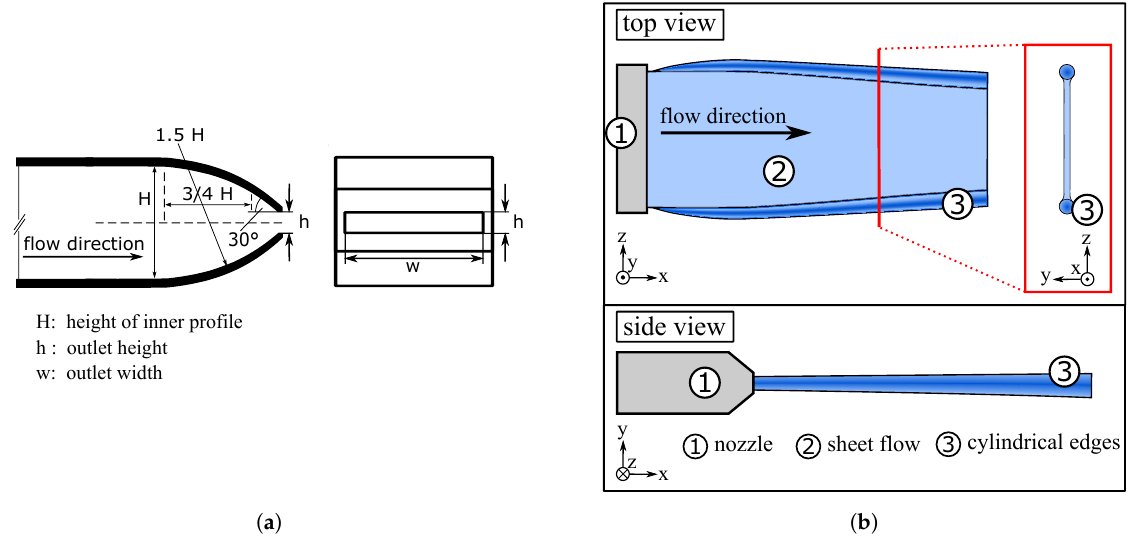
Figure 3. Free jet and nozzle orifice geometry. ( a ) Technical sketch of the Rouse-nozzle; ( b ) Free jet geometry generated by rectangular nozzle